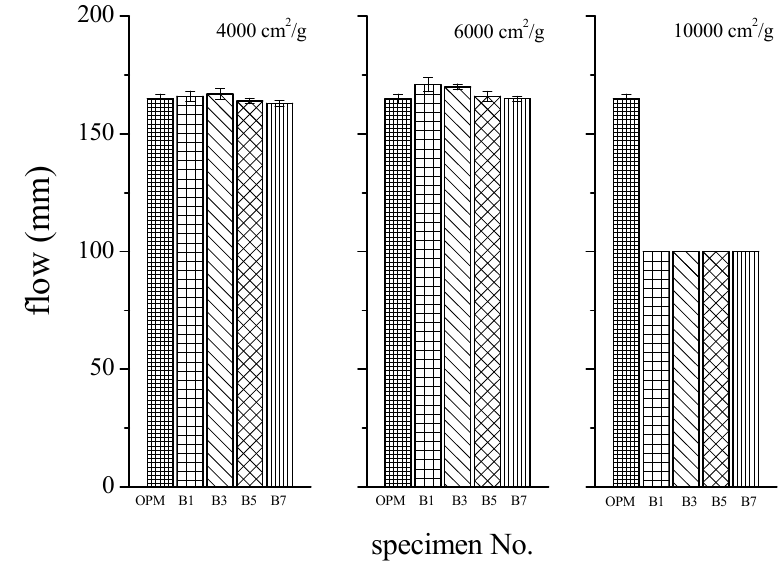
Figure 7. Flow test results of BOFS specimens.